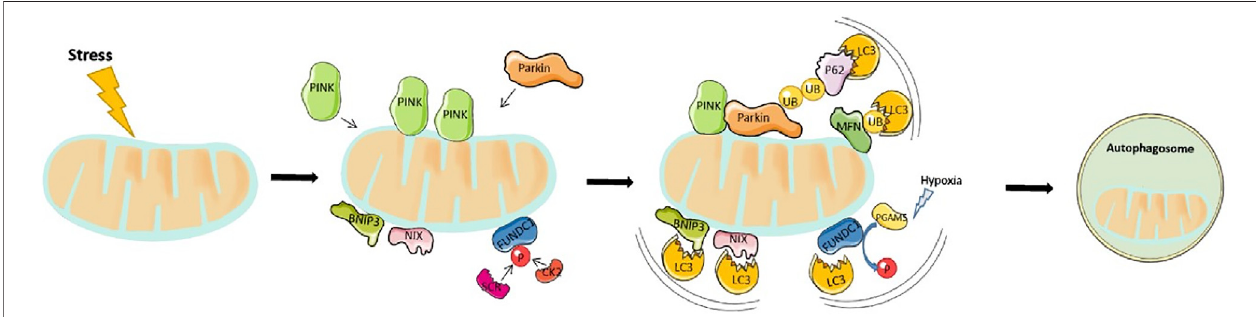
FIGURE 2 | Overview of mitophagy pathway: Mitophagy is driven by either Parkin-dependent or independent pathways. Under stress, PINK1 accumulates in the outer mitochondrial membrane (OMM) and promotes Parkin recruitment. Activated Parkin, in turn, promotes ubiquitination of the outer membrane proteins. p62 recognizes phosphorylated poly-Ub chains on mitochondrial proteins and binds to LC3 to initiate the formation of autophagosome. On the other hand, the mitophagy receptors, BNIP3, NIX, and FUNDC1 localize to the OMM, and interact directly with LC3 to mediate mitochondrial